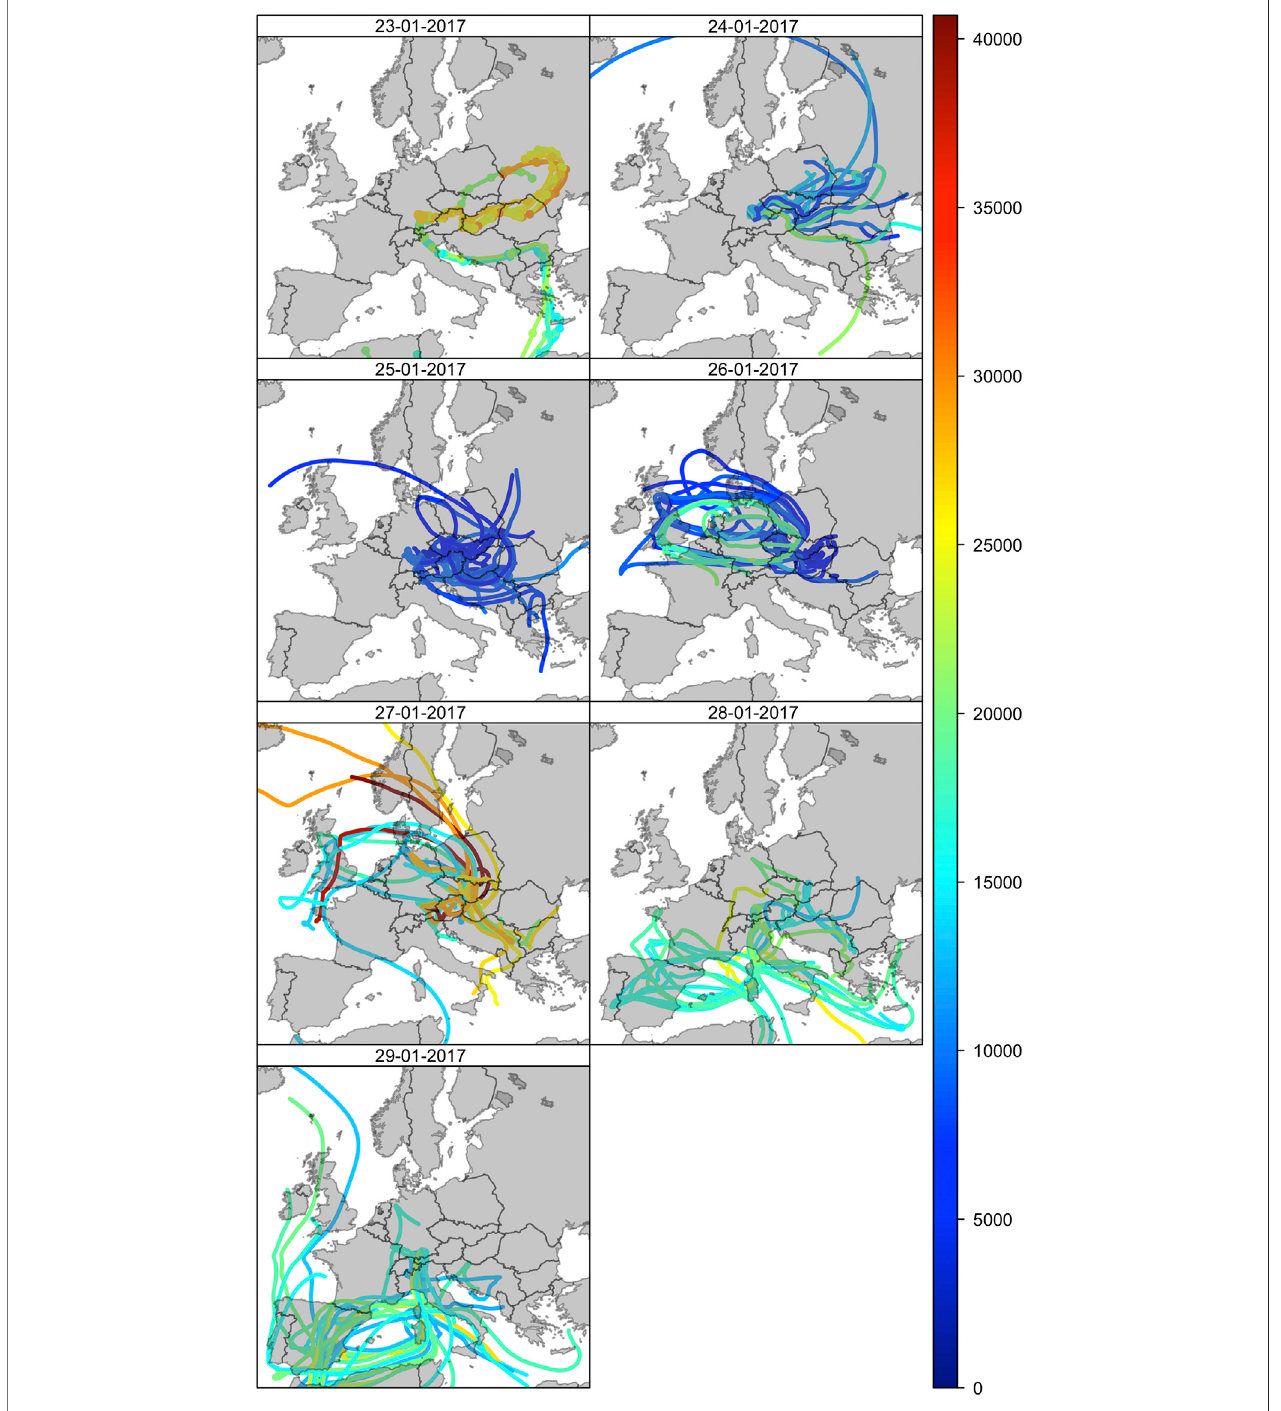
FIGURE 12 | Hourly 7-day backward trajectories over Augsburg using the trajectory model FLEXTRA based on the ECMWF reanalysis fi elds [The colours of the individual trajectories correspond to the UFP number concentrations (in particles/cm 3 ) that prevailed when the air masses arrived in Augsburg].